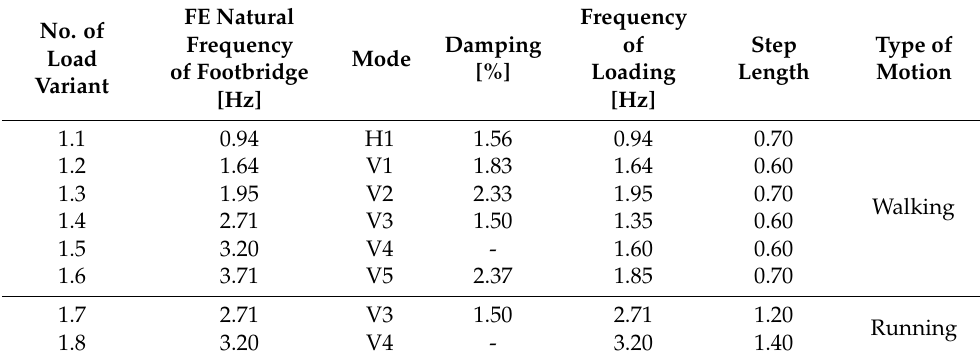
Table 9. The basic load variants vs. the modal parameters of the footbridge. The adopted damping values are those defined in 2019